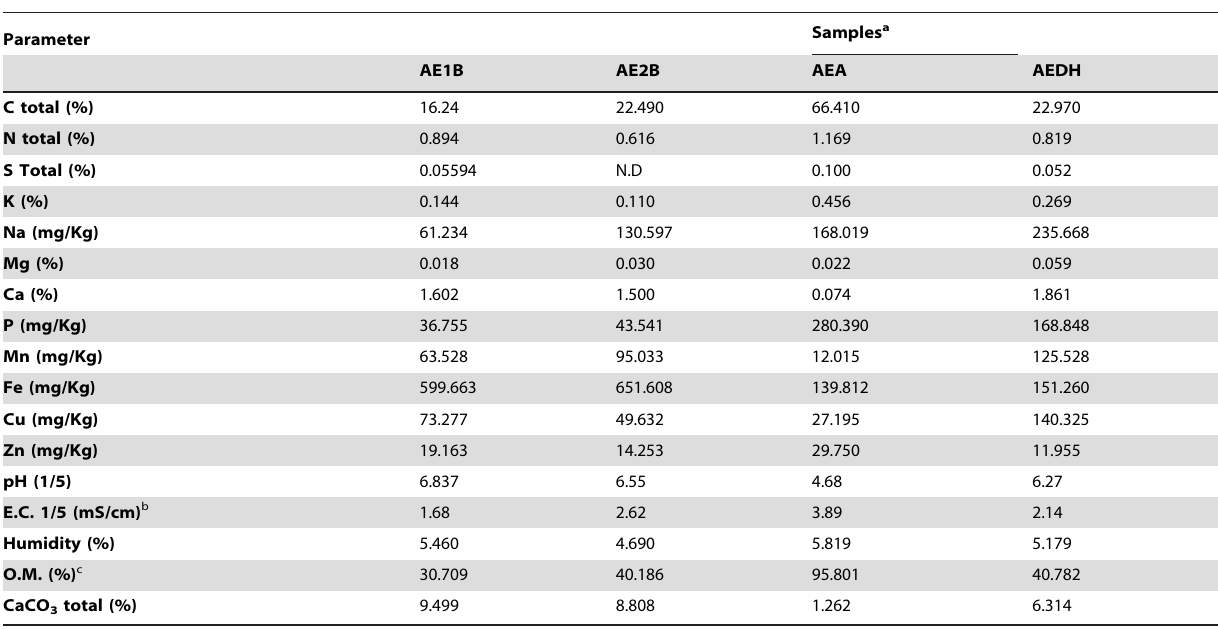
Table 1. Chemical and physico-chemical analysis of the oil mill samples.